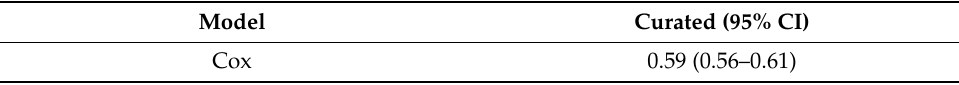
Table A2. Cox model performance (AUC) using “curated” dataset with two-way interactions and restricted cubic spline.